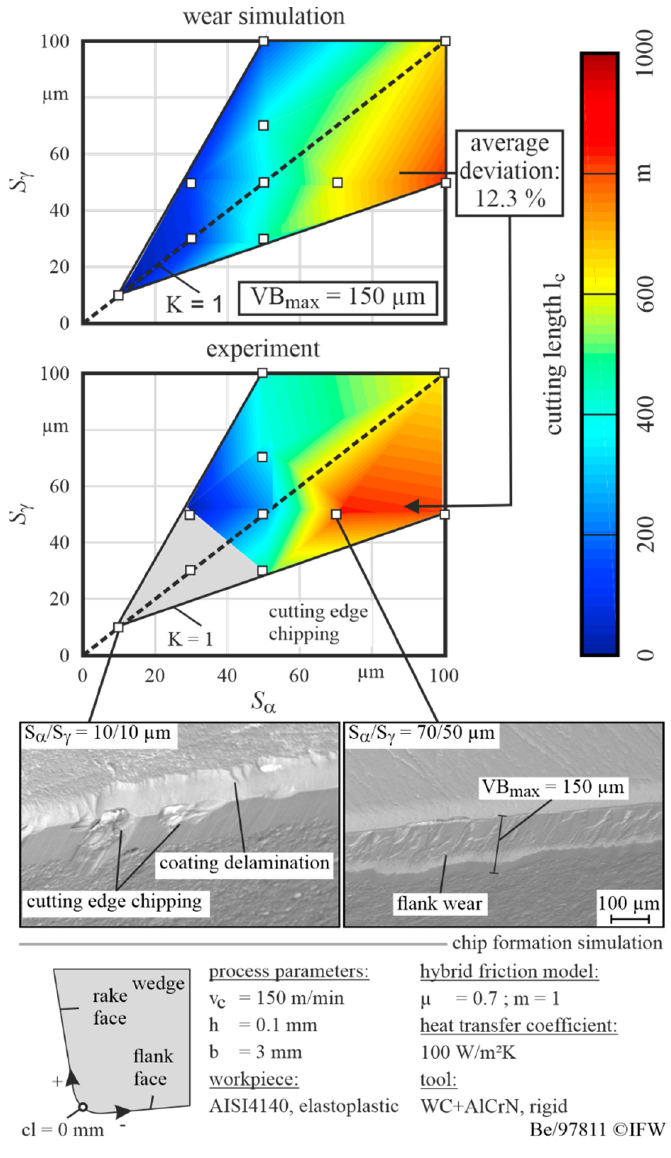
Figure 14. Comparison between simulated and experimental tool life time.